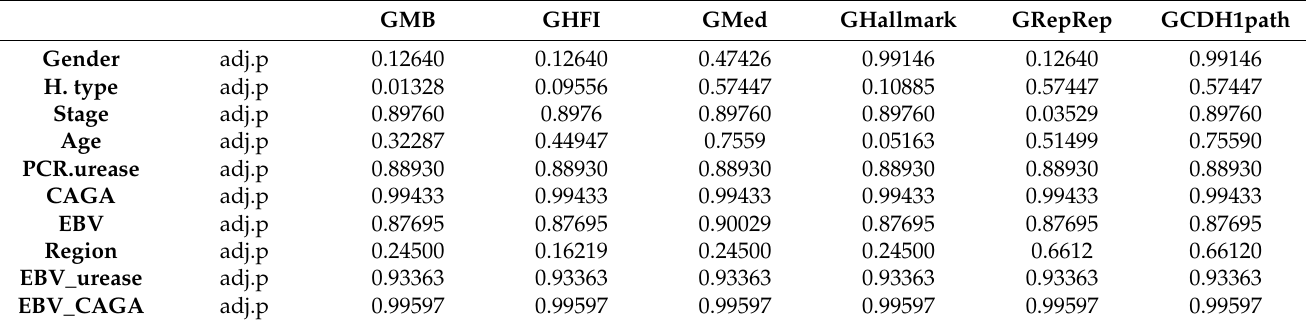
Table 1. Statistical analysis of subsets by clinical data; FDR was used to adjust p